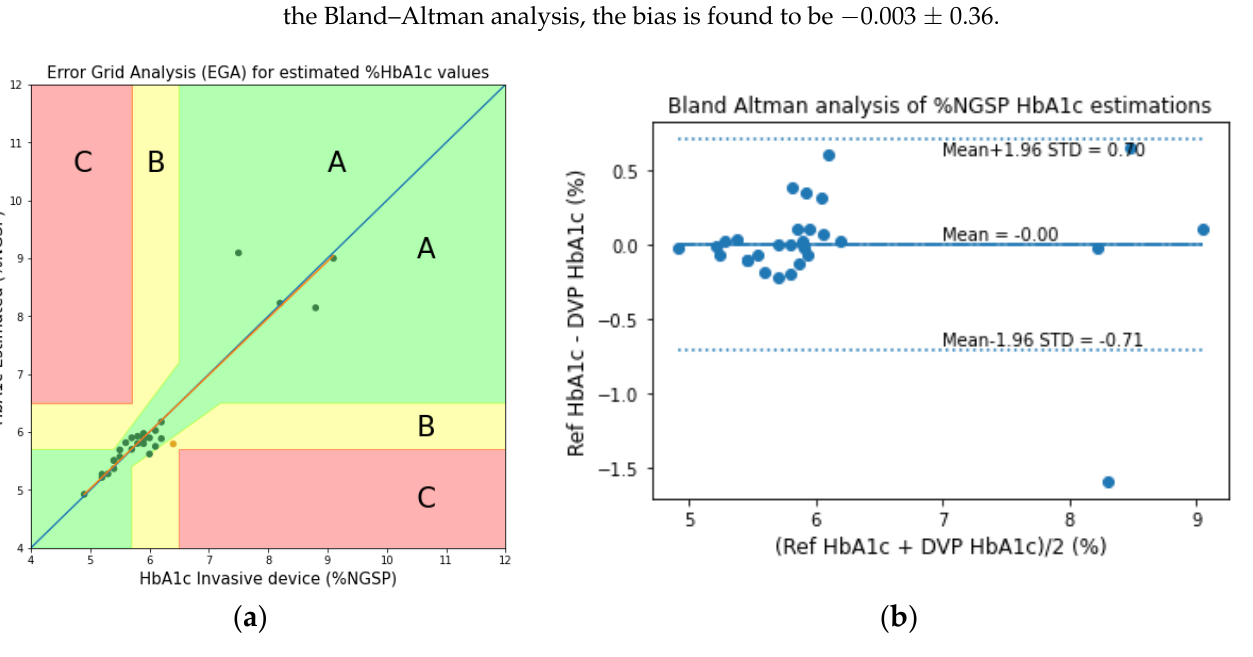
Table 4. Evaluation metrics of HbA1c for the transmission-type fingertip model.